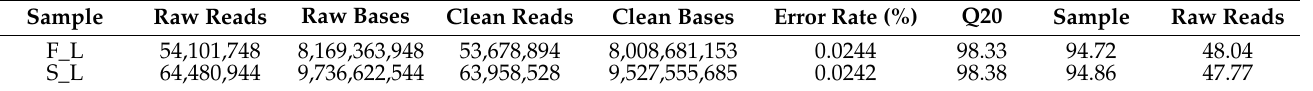
Table 1. Formulation and nutritional composition of commercial feed.